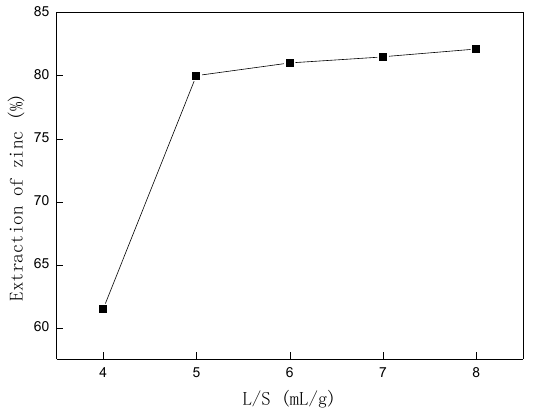
Figure 6. Effect of L/S (time 30 min, concentrations of ammonia and ammonium chloride, 2.5 mol/L and 5 mol/L respectively, temperature 40 °C).